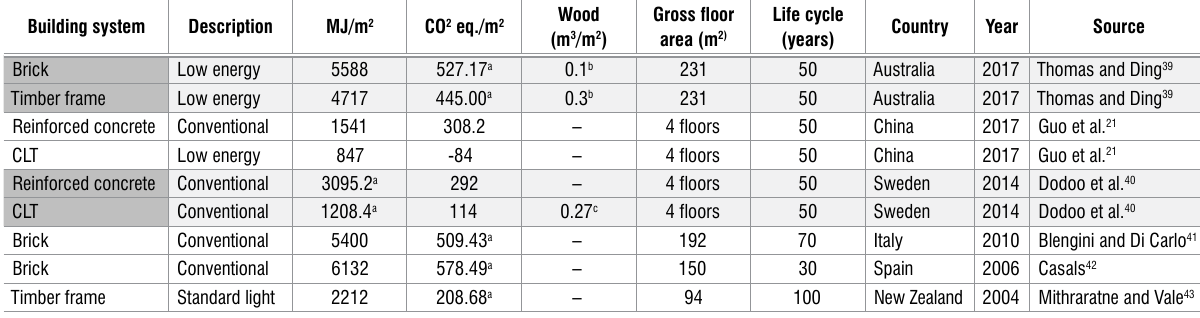
Reinforced concrete